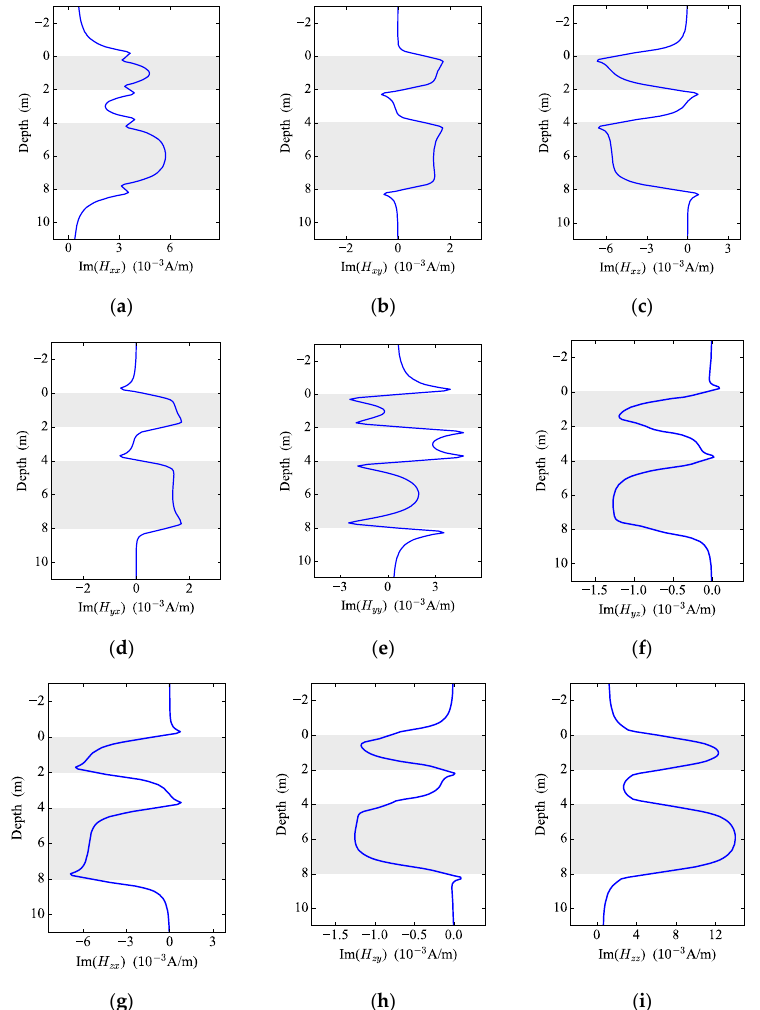
Figure 14. Responses of the tool in the layered full-tensor BA formation. ( a ) Im ( H xx ) . ( b ) Im ( H xy ) . ( c ) Im ( H xz ) . ( d ) Im ( H yx ) . ( e ) Im ( H yy ) . ( f ) Im ( H yz ) . ( g ) Im ( H zx ) . ( h ) Im ( H zy ) . ( i ) Im ( H zz )